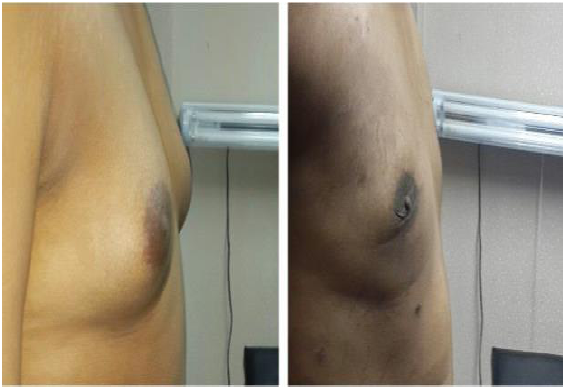
Figure 8 (a) Showing anteroir Simon 2B veiws befor and after operation